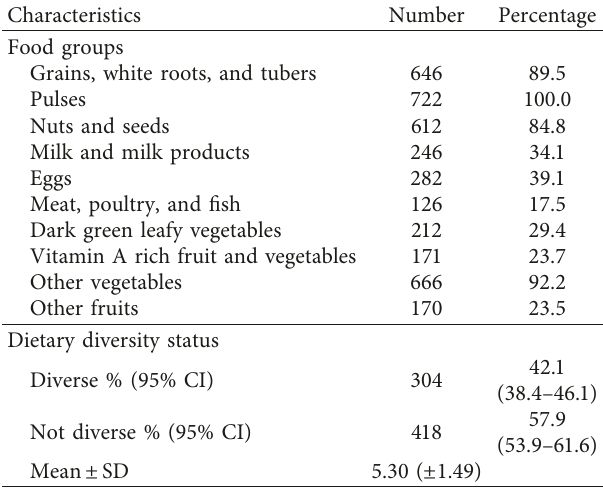
Table 4: Dietary diversity practice of study participants in the Gurage zone, southwest Ethiopia, September to November 2021 ( n � 722).